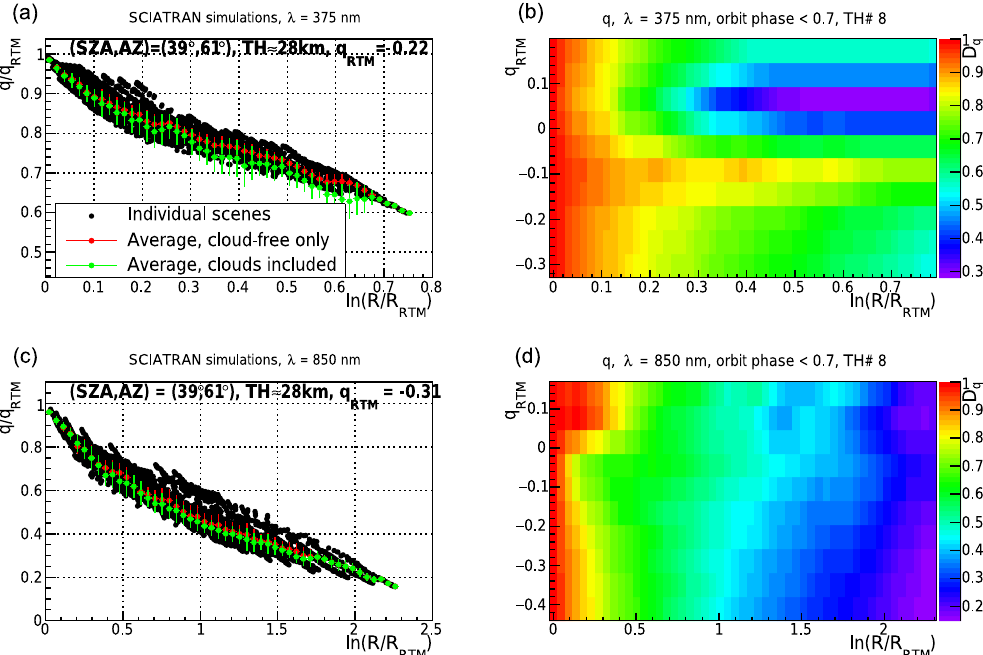
Figure 5. Example for the derivation of LUTs for the depolarization in limb geometry, TH ≈ 28km. (a) and (b) are for 375nm (i.e., PMD 1); (c) and (d) are for 850nm (i.e, PMDs 4 and 7). On the left the depolarization for a fixed geometry is plotted vs. log (R/R RTM ) ; on the right the 2D LUTs are shown as q/q RTM = f (q RTM , log (R/R RTM )) in a rainbow color scale.